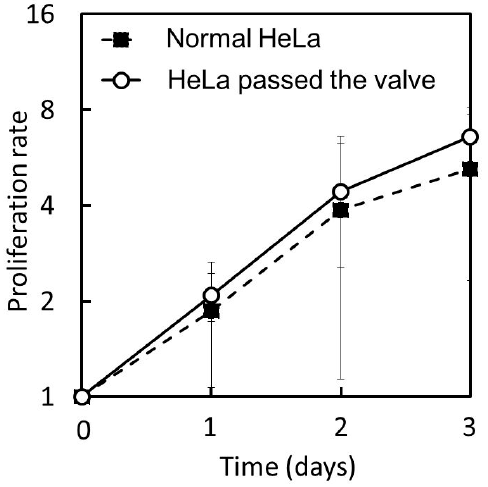
Figure 16. Proliferation curves of the HeLa cells passed and not passed (“Normal”) through the microvalve.